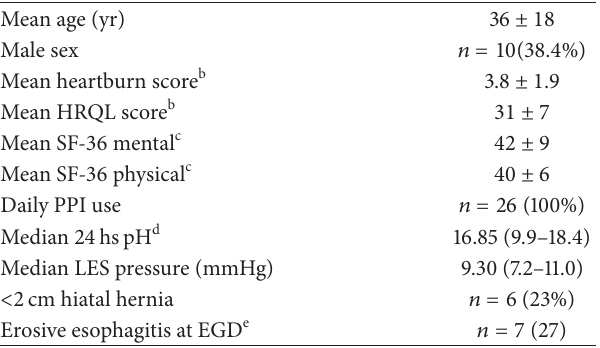
Table 1: Baseline characteristics of patients who reached an 8-year follow-up after Stretta procedure ( 𝑛 = 26 ) a .